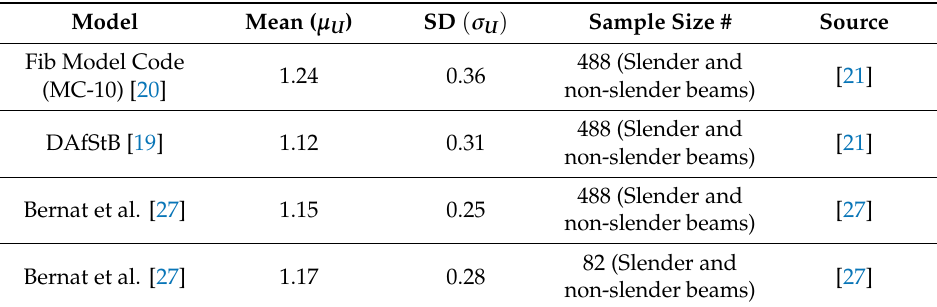
Table 1. Model uncertainty statistics obtained from the